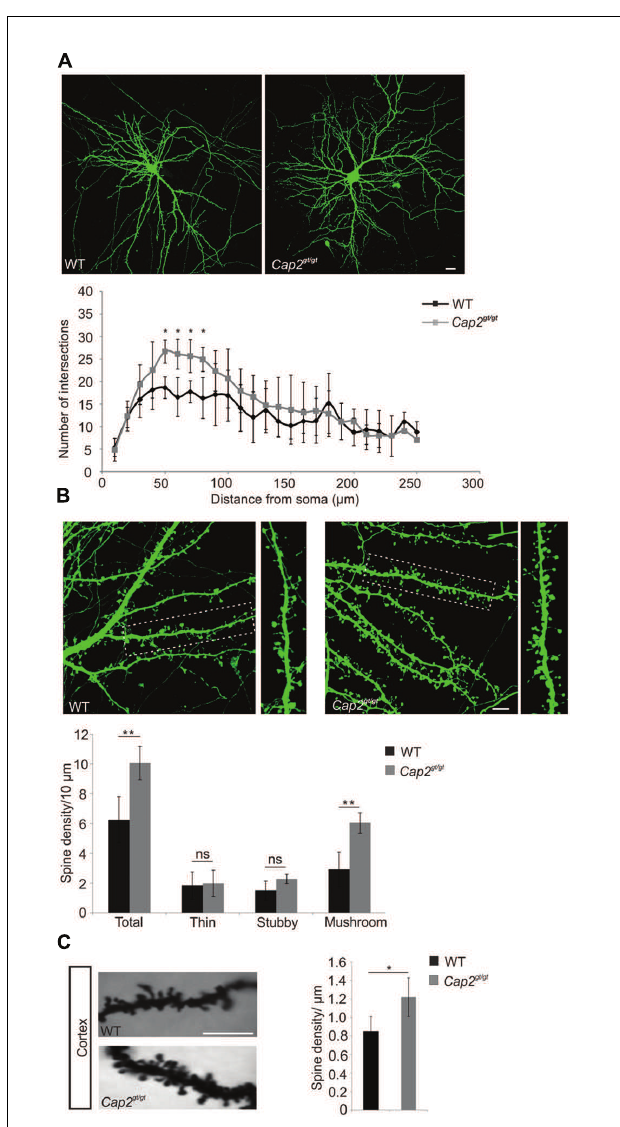
FIGURE 3 | Neuronal dendritic complexity and spine density is altered in mutant neurons. (A) An increase in dendritic complexity and dendritic spine was observed at div 16 in cultured cortical neurons labeled with pEGFP-C2. Sholl analysis revealed the number of dendrite intersections of cortical neurons (Scale bar, 20 µ m, p < 0.05). (B) Primary cortical neurons from WT and CAP2 mutant mice transfected with pEGFP-C2 show an increased linear density of dendritic spine in mutant neurons (WT: 6.3 ± 1.5 spines/10 µ m, n = 20 neurons from 3 different cultures; Cap2 gt / gt : 10.1 ± 1.1 spines/10 µ m, n = 15 neurons from 3 different cultures, p < 0.01) and of mushroom-like dendritic spines (WT: 2.9 ± 1.2 spines/10 µ m, n = 20 neurons from 3 different cultures; Cap2 gt / gt : 6.0 ± 0.7 spines/10 µ m, n = 15 neurons from 3 different cultures, p < 0.01). Stubby-like (WT: 1.5 ± 0.6 spines/10 µ m, n = 20 neurons from 3 different cultures; Cap2 gt / gt : 2.3 ± 0.3 spines/10 µ m, 15 neurons from 3 different cultures, p > 0.05) and Thin-like (WT: 1.8 ± 0.9 spines/10 µ m, n = 20 neurons from 3 different cultures; Cap2 gt / gt : 2.0 ± 0.9 spines/10 µ m, n = 15 neurons from 3 different cultures, p > 0.05) dendritic spines were not altered. Scale bar, 20 µ m. (C) Golgi cox staining in WT and CAP2 mutant cortex and quantification revealed an increase in spine density (WT: 0.85 ± 0.17 spine/ µ m; Cap2 gt / gt : 1.2 ± 0.2 spine/ µ m, n = 20 neurons from 3 different mice, p < 0.05). Scale bar, 20 µ m. ∗ p < 0.05, ∗∗ p <